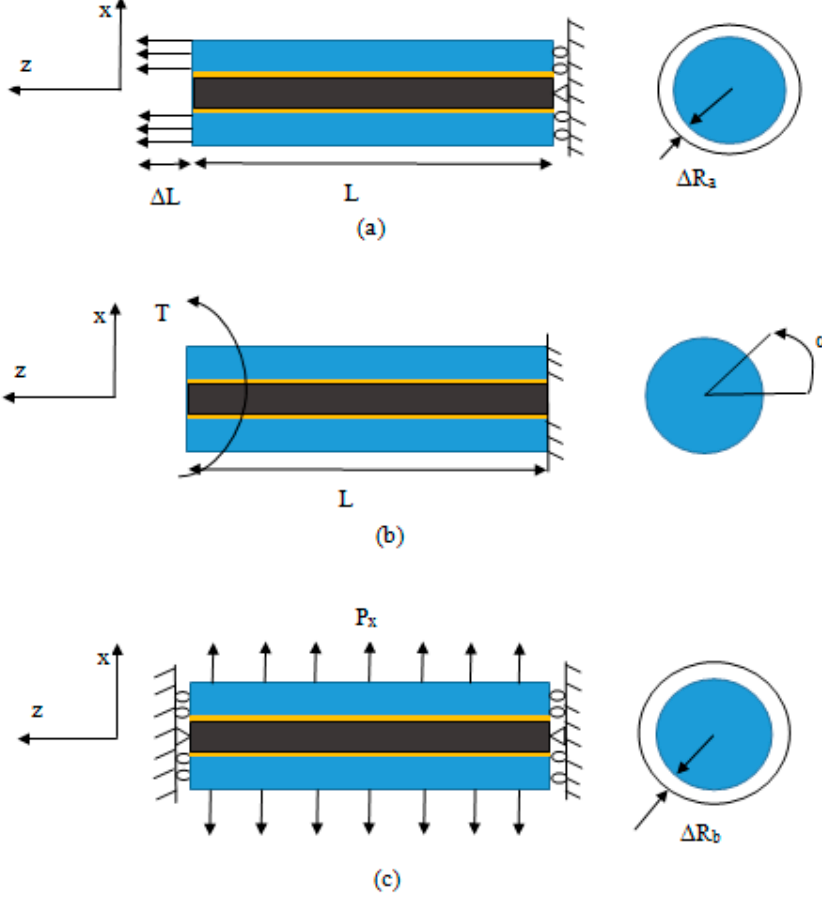
Figure 7 . Performing ( a ) axial tensile; ( b ) torsional; and ( c ) transverse tests in simulation. Calculation of the longitudinal Young’s modulus :